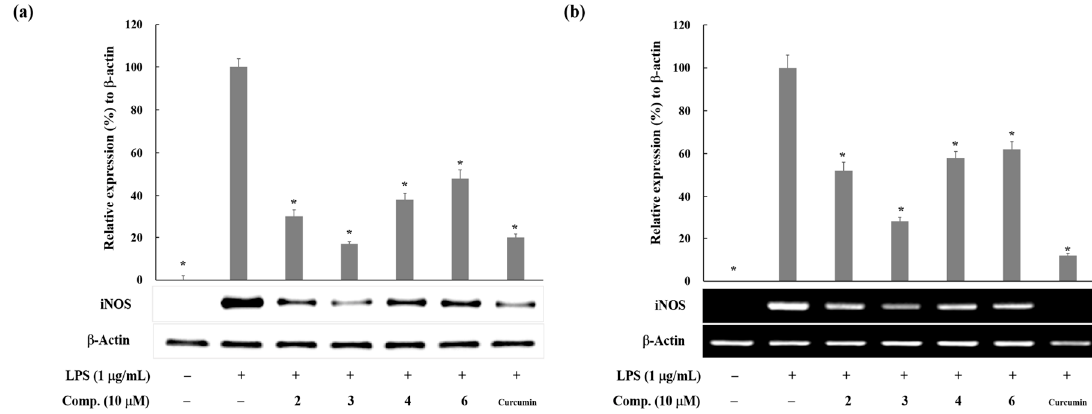
Figure 2. The inhibitory effects of Compounds 2 – 4 and 6 from B. kazinoki on LPS-induced iNOS expressions. ( a ) Effect of Compounds 2 – 4 and 6 on iNOS protein levels in LPS-activated RAW 264.7 cells. iNOS and β -actin protein levels were determined by Western blotting. The relative intensity of iNOS to β -actin bands was measured by densitometry. The values express the means ± S.D. of three experiments. * p < 0.05; ( b ) Effect of Compounds 2 – 4 and 6 on iNOS mRNA levels in LPS-activated RAW 264.7 cells. The mRNA levels of iNOS and β -actin were determined by RT-PCR. The relative intensity of iNOS to β -actin bands was measured by densitometry. The values express the means ± S.D. of three experiments. * p < 0.05. Curcumin was used as the positive control. Images are the representative of three independent experiments with similar results.